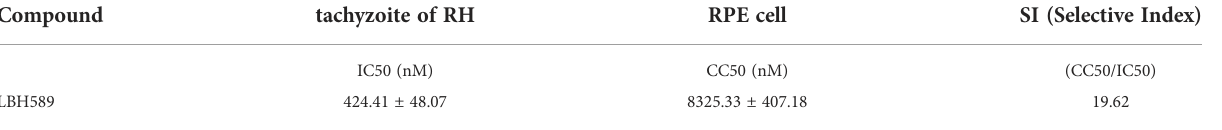
TABLE 2 Selective Indexes for RPE cells after treatment with LBH589 for 48 h.